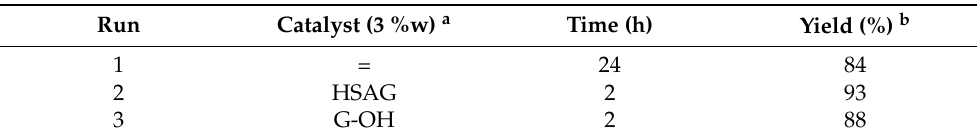
Table 4. Reaction between butylisocyanate (But-NCO) and butanol (But-OH): reaction conditions,